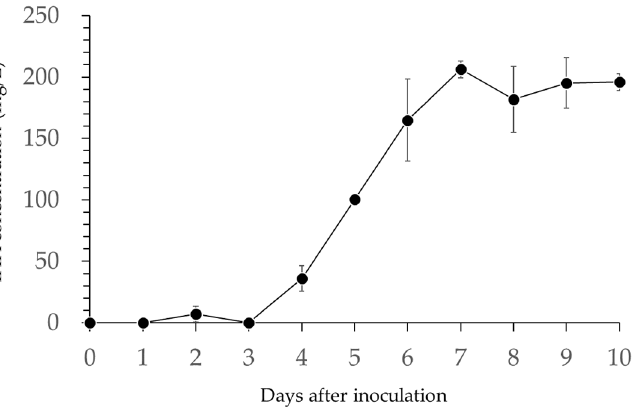
Figure 5. Changes in indole-3-acetic acid (IAA) production in mg/L by B. licheniformis PR2, in vitro.